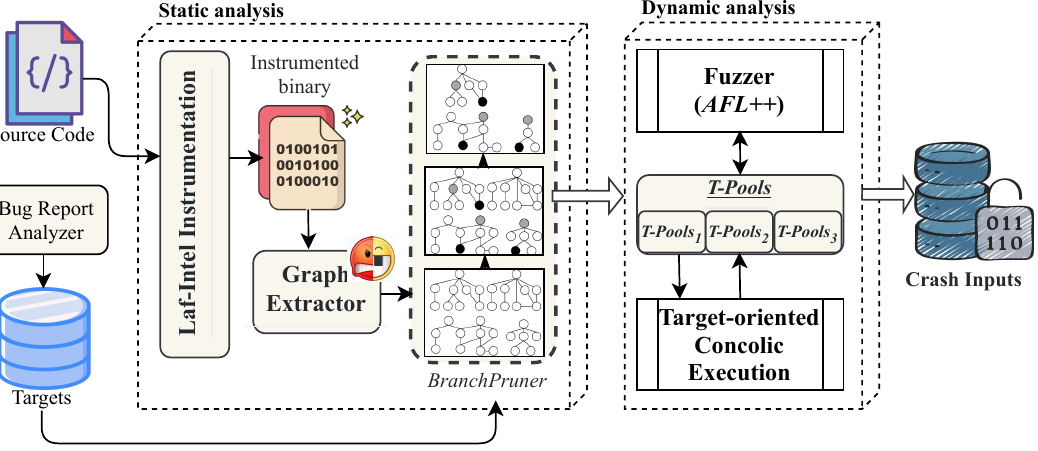
Figure 1. BugMiner overall workflow.